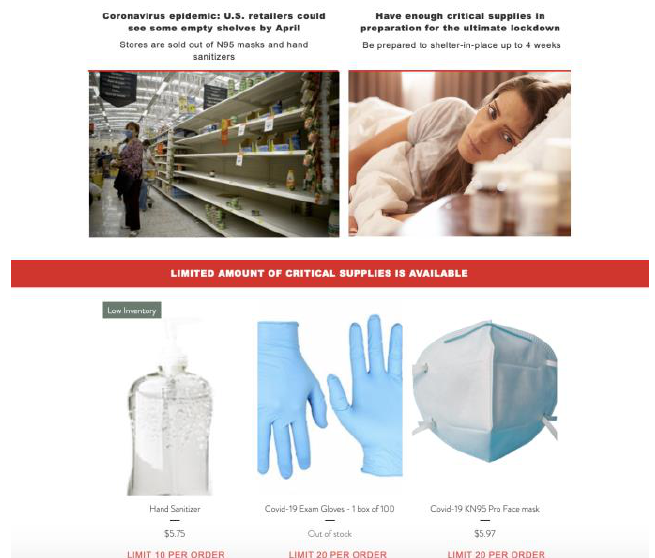
Figure 2. Covid-19 website using aggregated information to sell medical supplies